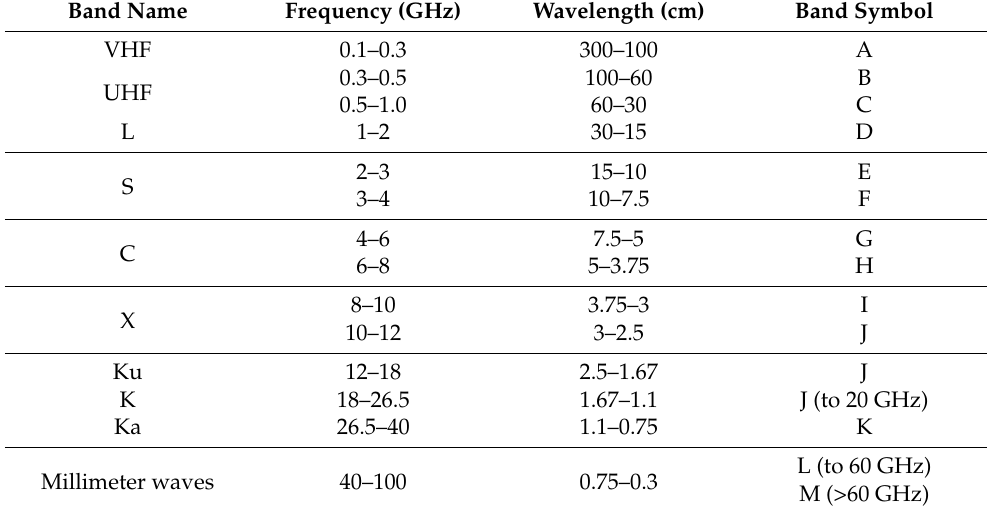
Table 1. Frequency division into bands